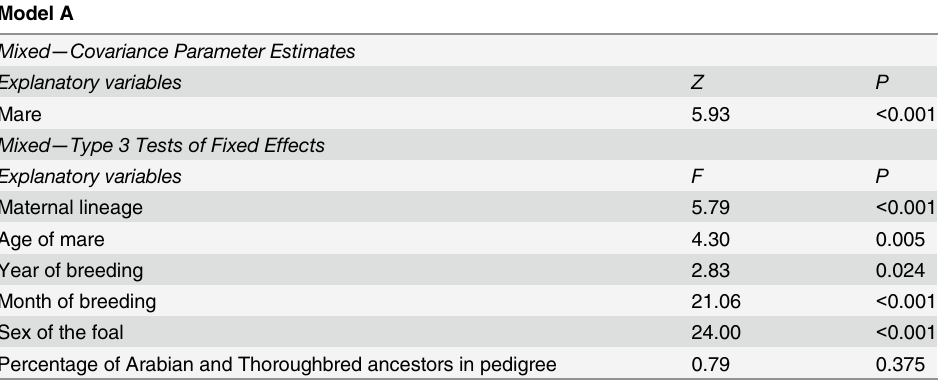
Table 2. Influence of different factors on gestation length (n = 640 pregnancies) in Warmblood mares (n = 142). Model A